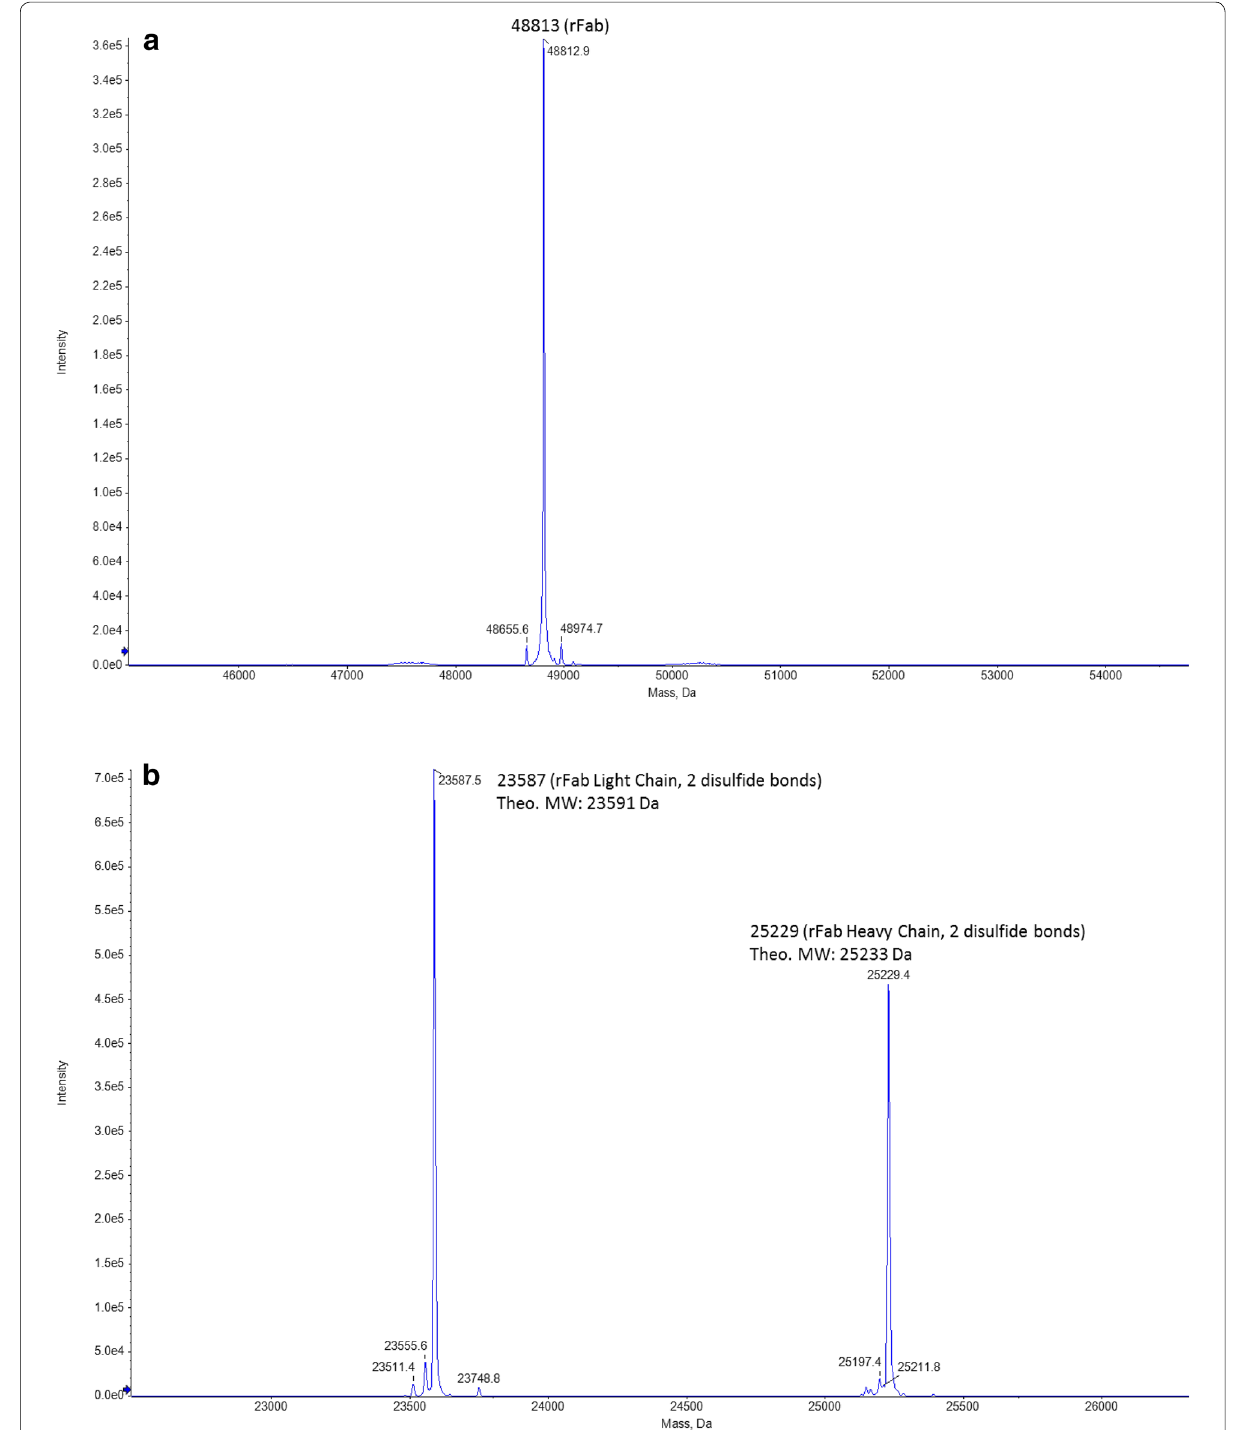
Fig. 8 a ESI–MS spectrum of rFab from 5 L bioreactor under non-reduced condition. The MW profile of rFab was observed at 48,813 Da, and no oxidized rFab was detected from 5 L bioreactor. b ESI–MS spectrum of rFab from 5 L bioreactor under TCEP-reduced condition. The MW at 23,587 Da matched with the light-chain theoretical MW with two disulfide bonds, and the MW at 25,229 Da matched with the heavy chain theoretical MW with two disulfide